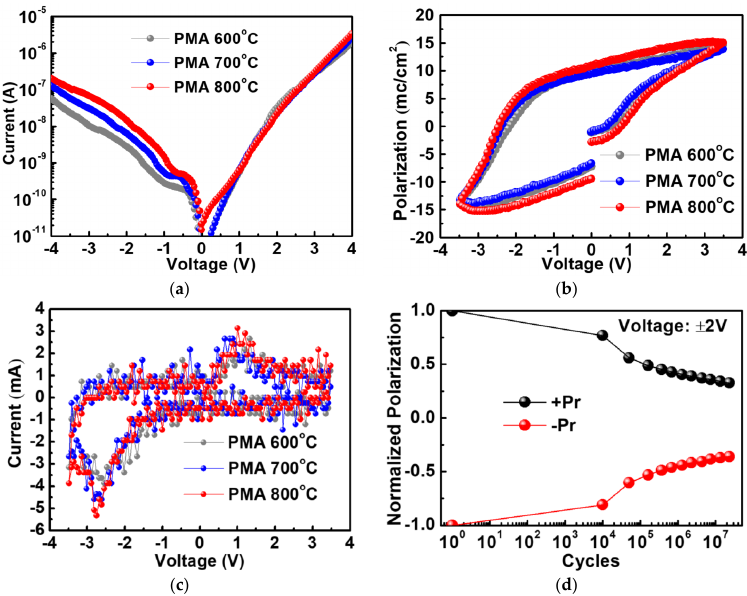
Figure 3. ( a ) I-V curves, ( b ) P-E hysteresis loop and ( c ) instantaneous current ( d ) endurance cycling characteristics of FE HZO MFM capacitors with different PMA temperatures. To further characterize the ferroelectric properties of the HZO capacitor, the PUND (positive up negative down) measurement was performed [13]. Figure 4a,b shows the PUND pulse waveform and